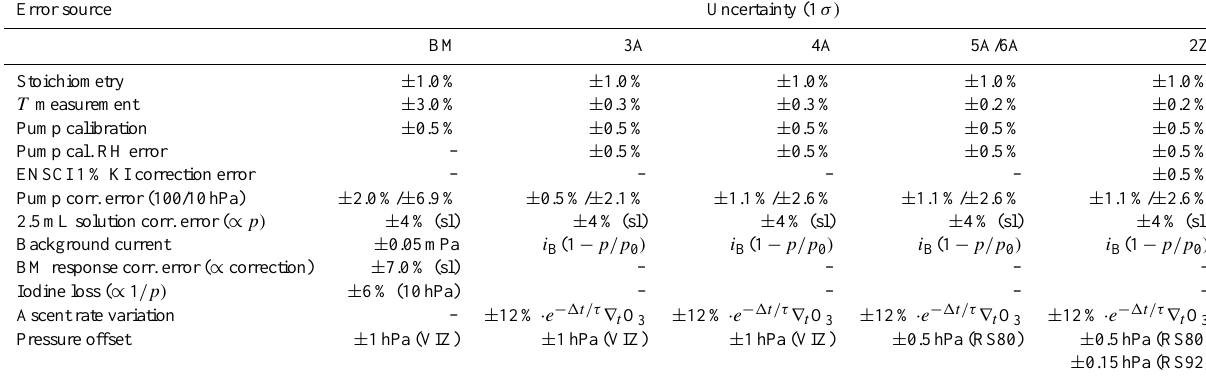
measurement in the 3A and 4A models was less accu- rate than the pump measurement used with later models; we have assumed a standard error of 0.5 K for the latter and 1.0 K for the former. – Pump flow measurement An examination of pre-flight volumetric pump flow measurement data from several sites shows that stan- dard deviations of 0.1–0.3 % in this measurement (per- formed the day before launch) are typical. However, dif- ferences between this measurement and the correspond- ing flow rate determination made at the manufacturer’s facility are larger, with standard deviations of about 1 %.